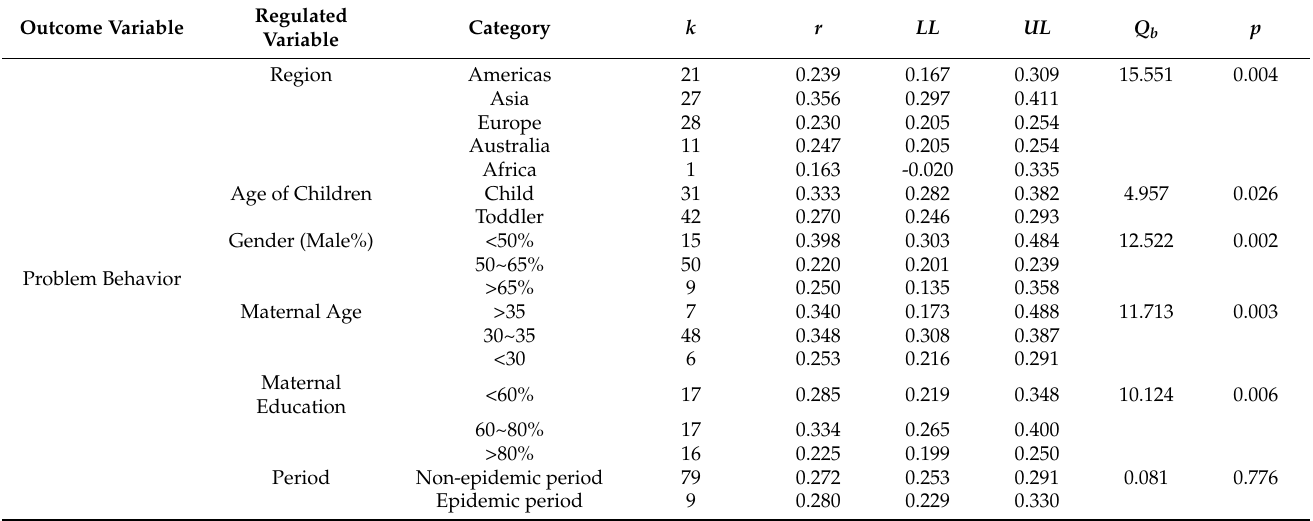
Table 5. Results of adjustment effect